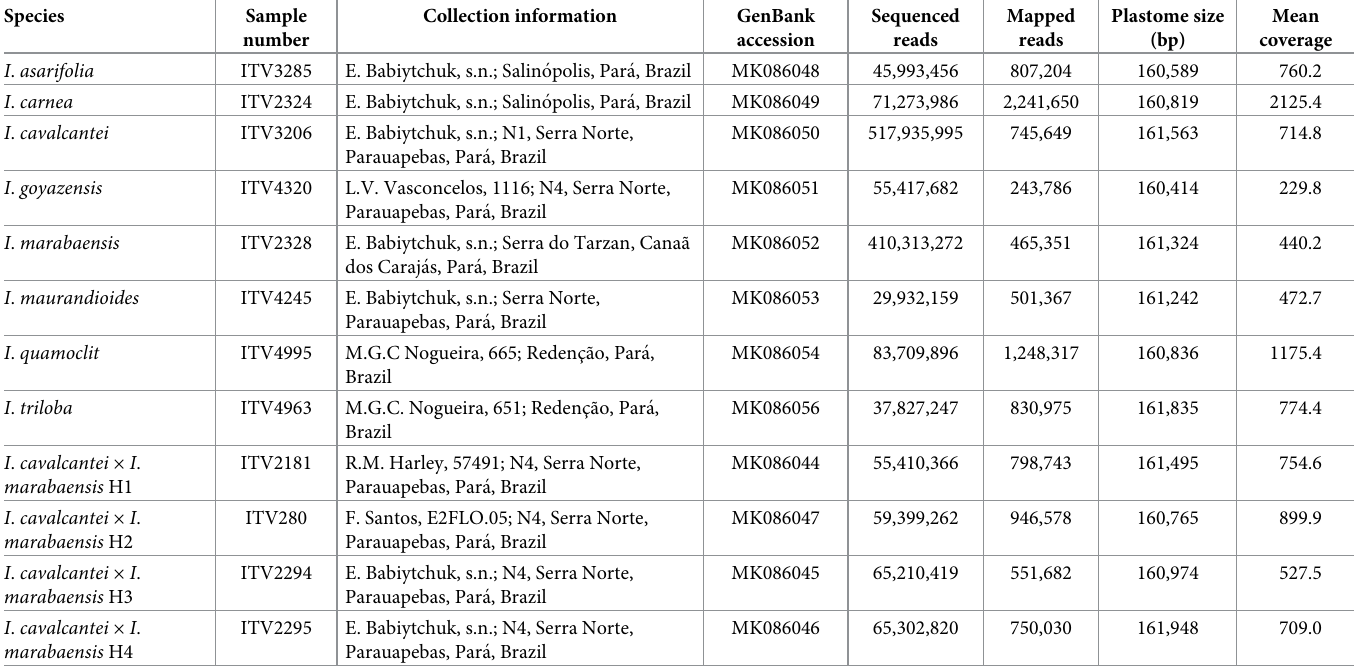
Table 1. List of Ipomoea lineages studied in the present work, including sampling information and plastome sequencing data for each analyzed specimen.